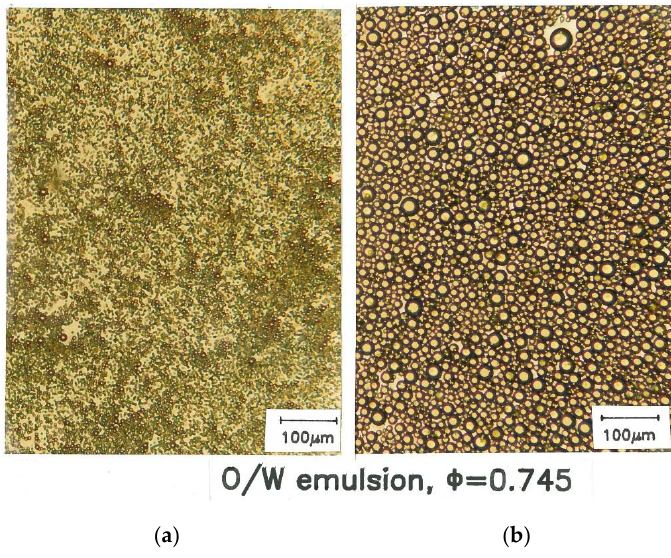
Figure 2. Photomicrographs of fine ( a ) and coarse ( b ) O/W emulsions.